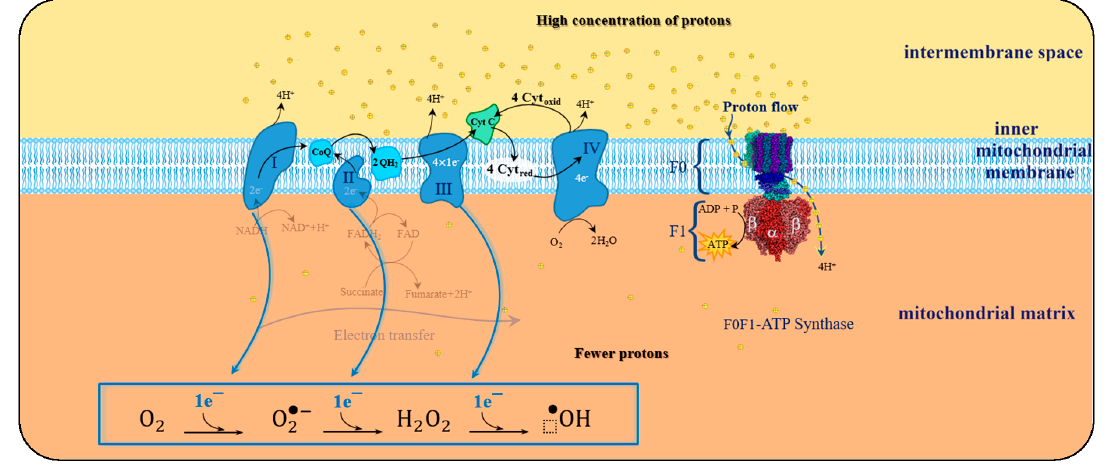
Figure 7. ROS generation by electron leakage during ETC of OP of mitochondrial respiratory